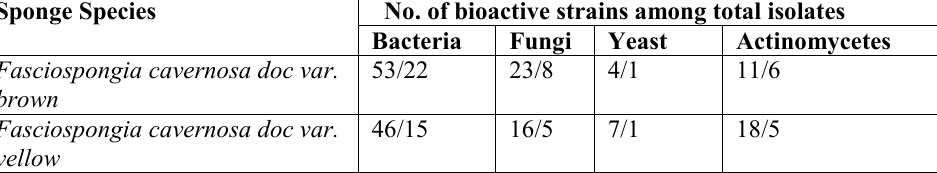
Table 4. List of bioactive actinomycetes from sponges. Sponge Species No. of bioactive strains among total isolates